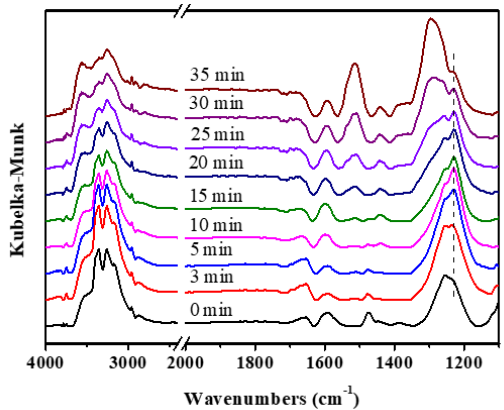
Figure 14. In situ DRIFTs spectra of the MnAlO x catalyst under an atmosphere of 500 ppm NO + 6.5 vol. %O 2 /N 2 at different times after adsorption of 500 ppm of NH 3 at 210 °C and flowing of N 2 for 30